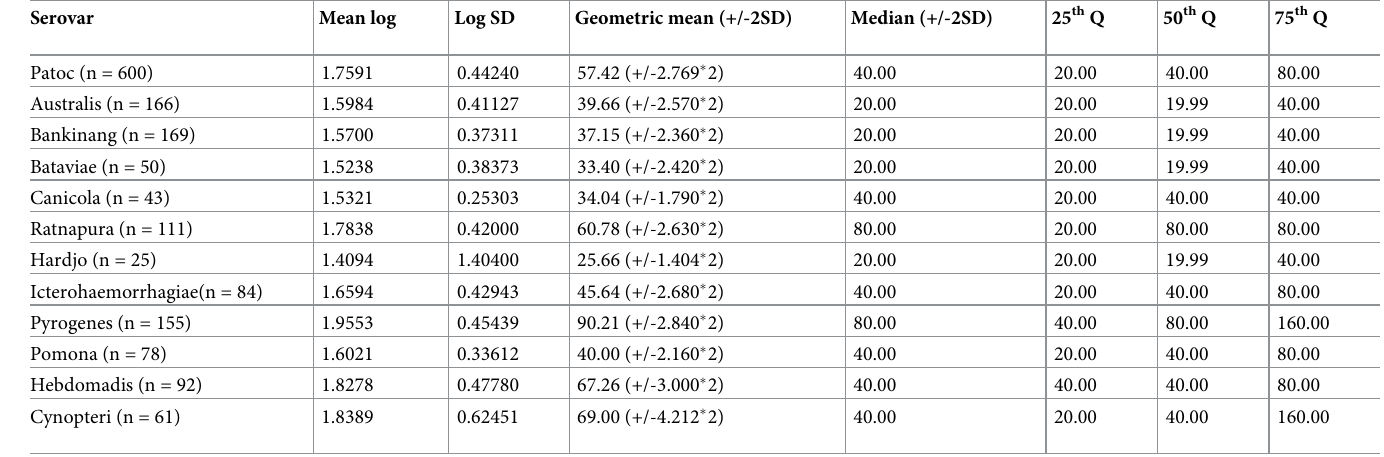
Table 3. Analysis of MAT titers.